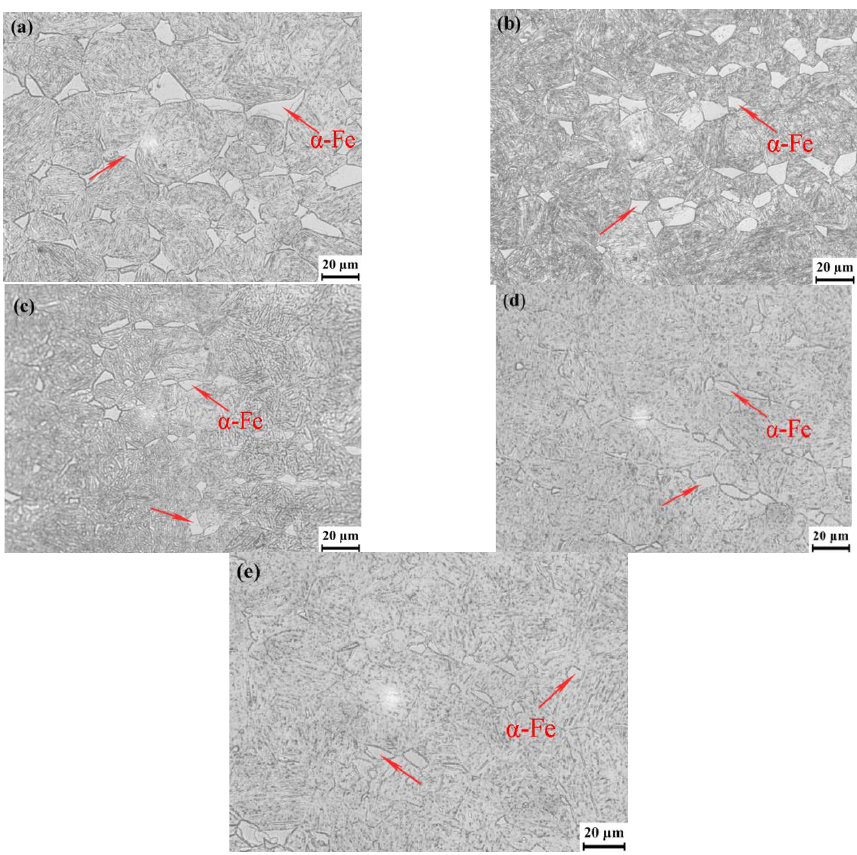
Figure 2. Microstructure of AISI 430 ferritic stainless steel, solid solution-treated at 1160 °C with annealing at different temperatures of (the red arrow refers to α- Fe). ( a ) A750, ( b ) A800, ( c ) A850, ( d ) A900, and ( e ) A950.